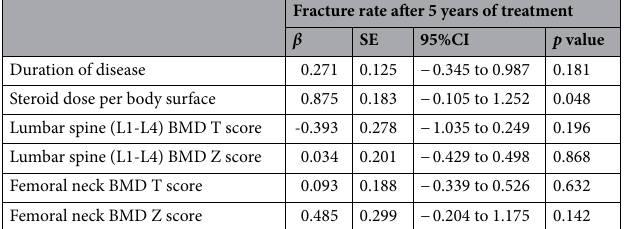
Fracture rate after 5 years of treatment β SE 95%CI p value